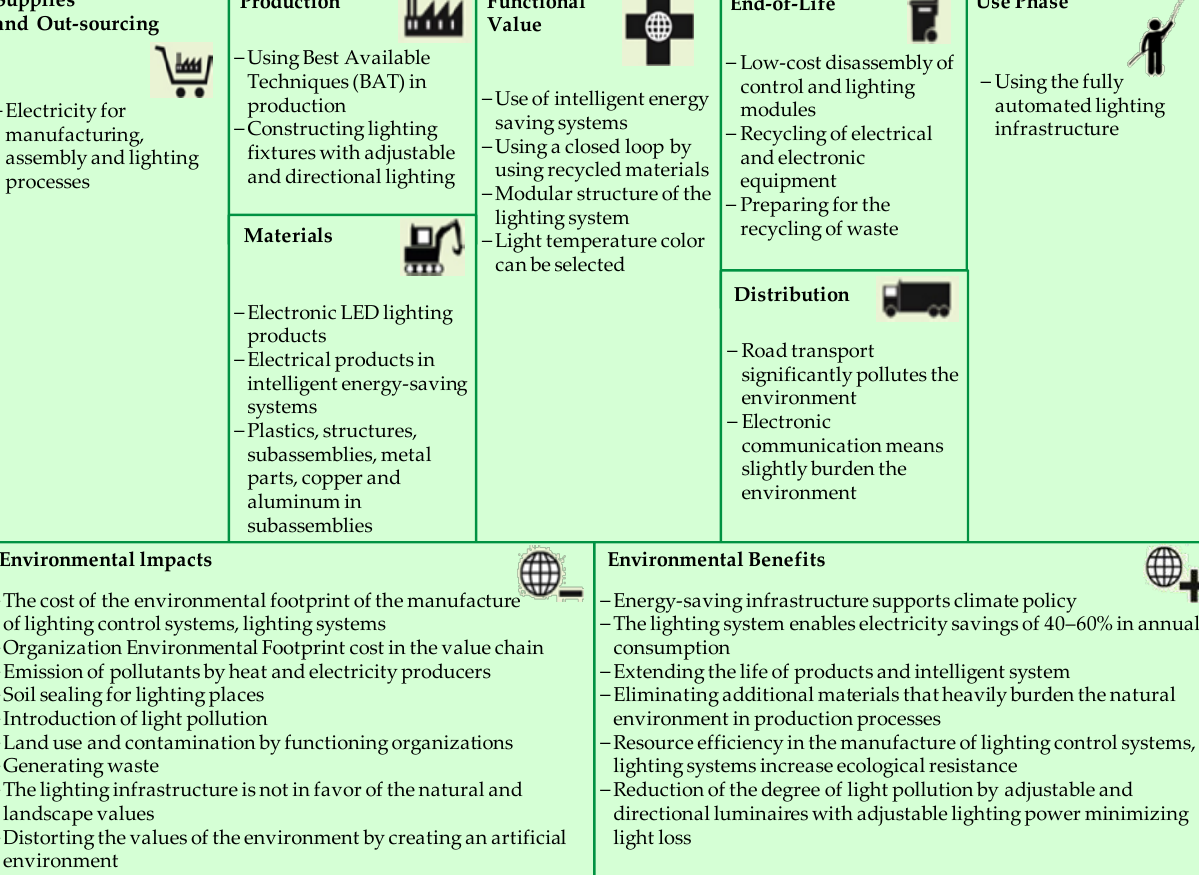
Figure 12. The environmental layer of sustainable development. Source: Own study based on the source [59].